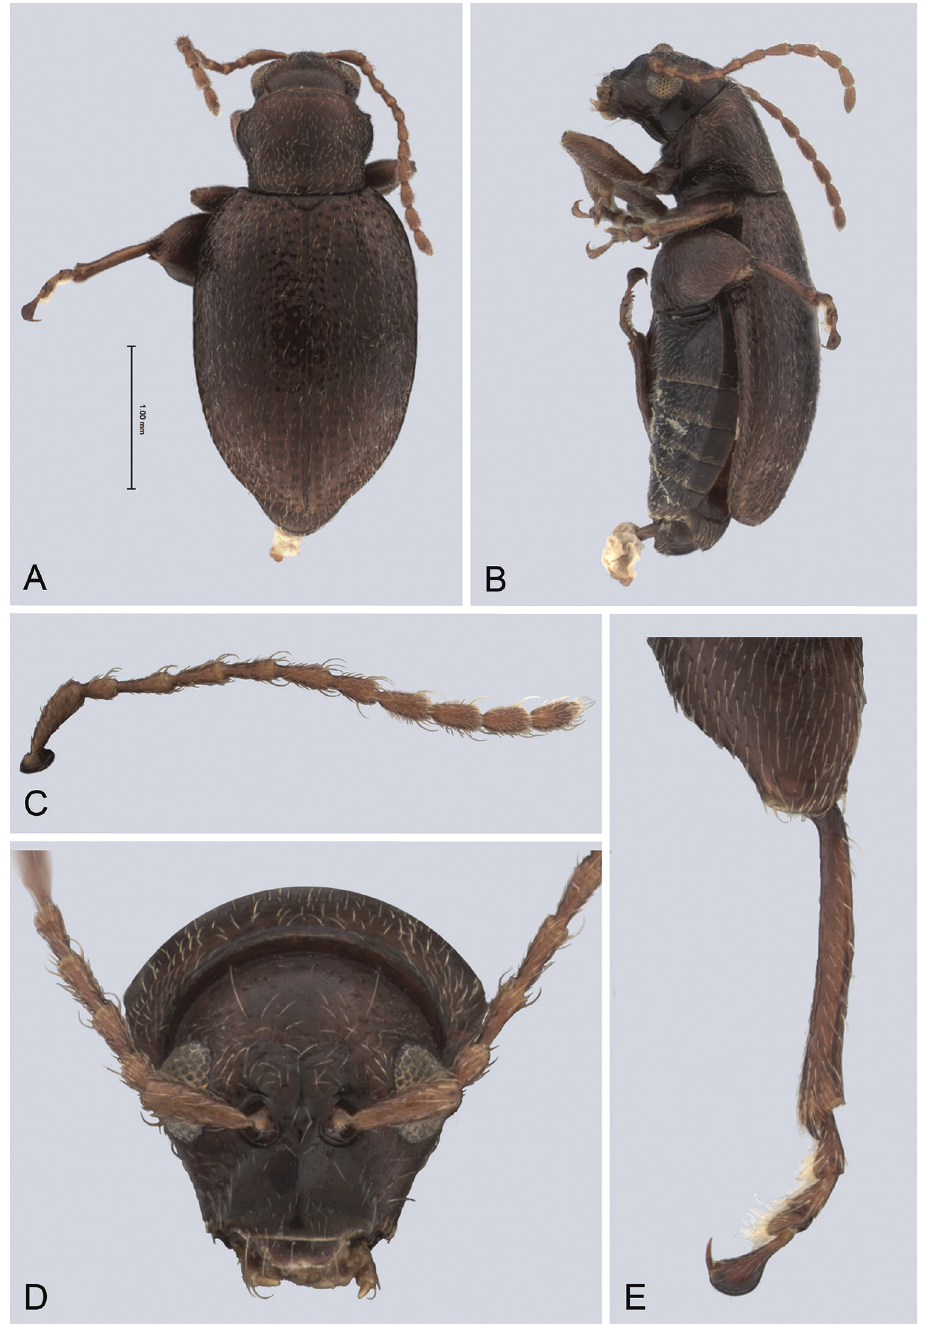
Figure 21. Andersonoplatus merida . A Habitus dorsal B Habitus lateral C Antenna D Head, frontal view E Hind